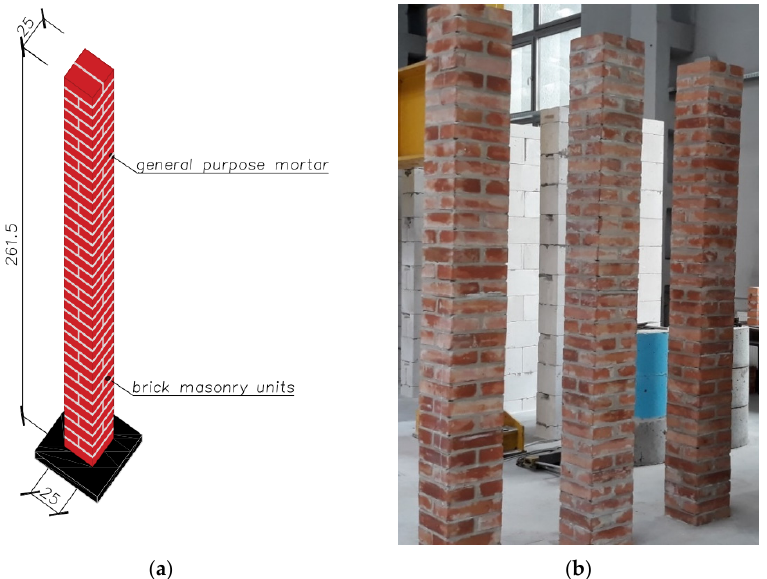
Figure 5. Shape and dimensions of the brick masonry pillar model in compression tests: ( a ) shape and dimensions of the pillar model ( b ) pillar models [23].